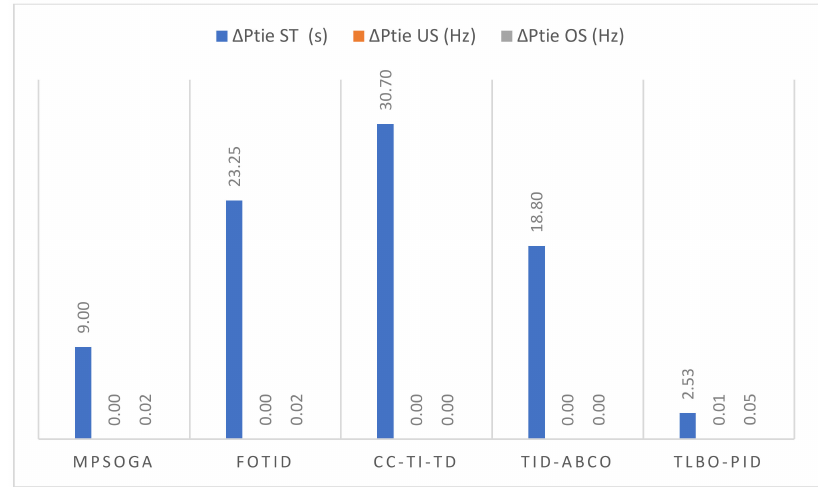
Figure 15. Frequency Deviation for Interconnected